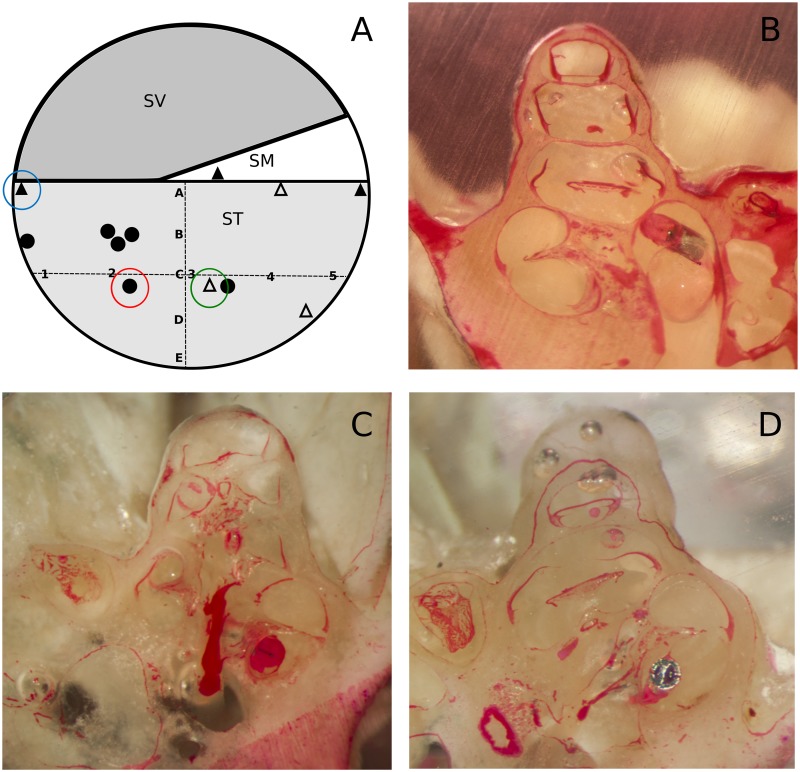
Electrode array placement in the cochlea.(A) Diagram of a cochlea section passing through the three scala (SV, scala vestibuli; SM, scala media; ST, scala tympani) with a classification according to the placement of electrodes. From A (close to the basilar membrane) to E in a vertical orientation, and from 1 (close to the modiolus) to 5 (close to the lateral wall) in a horizontal orientation. Black circles correspond to electrode placement without hearing loss at D30, black triangles correspond to electrode placement with hearing threshold shift >40 dB at D30 without fibrosis, and light grey triangles correspond to fibrosis. (B) Macroscopic anatomy section of an electrode array in A placement, in contact with a fracture of the osseous spiral lamina (blue circle in A). (C) Macroscopic anatomy section of an electrode array in 4C placement surrounded by reaction fibrosis * (green circle in A). (D) Macroscopic anatomy section of an electrode array in 2C placement away from basilar membrane and osseous spiral lamina (red circle in A).